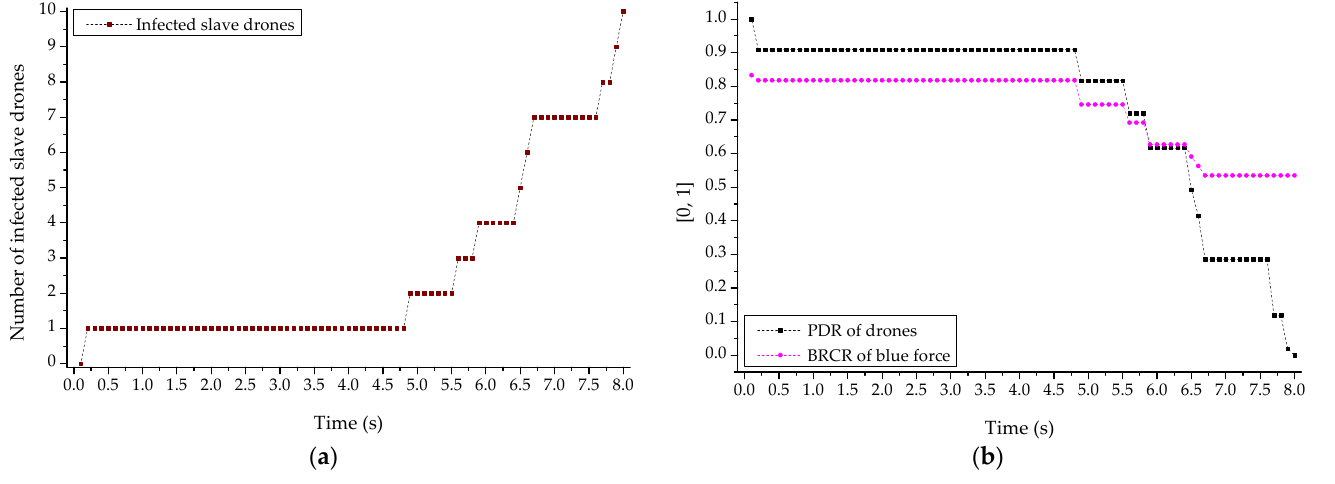
Figure 18. PDR (packet delivery ratio) and BRCR (blue remaining combat ratio) graph by network worm propagation and infection. ( a ) Graph of infected drones according to network worm, ( b ) PDR (packet delivery ratio) and BRCR (blue remaining combat ratio) graphs according to the increase in infected drones.